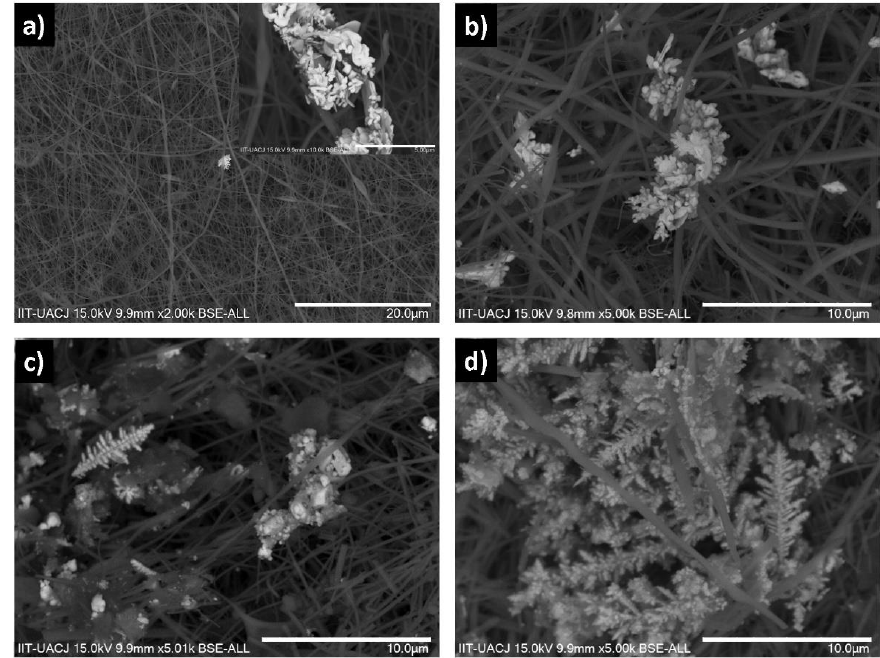
Figure 3. SEM micrographs of silver-doped fibers at 5 mM AgNO 3 during: ( a ) 1, ( b ) 2, ( c ) 5 and ( d ) 10 min. Treatment of 1 min at a concentration of 10 mM led to the formation of defined den- dritic structures. Figure 4a shows the average dendrite size in 9.11 ± 5.88 µm, with a width of 2.23 ± 1.43 µm. The EDX spectrum in the fibers confirmed the composition of silica- titania-silver. The 2 min electrolytic treatment revealed heterogeneous behavior regarding the position of the particles, as shown in Figure 4b, but with preferential longitudinal growth. At the tip of some dendrites, it is possible to observe how hexagonal silver crystals are formed. The average length of the dendrites was 6.55 ± 2.25 µm, with a width of 1.38 ± 0.58 µm. Figure 4c shows the fibers doped for five minutes at a concentration of 10 mM, approximately six silver hexagonal crystals were deposited on the silica-titania fibers. Sil- ver dendritic structures have an average length of 3.70 ± 1.95 µm, and an average width of 0.92 ± 0.56 µm. Micrographs at these concentration and voltage conditions show branching nuclei, and dendritic growth is decreased by a preference for longitudinal growth over the fibers. The doped fibers obtained at 10 min of electrolytic treatment in Figure 4d show the formation of amorphous silver particles.